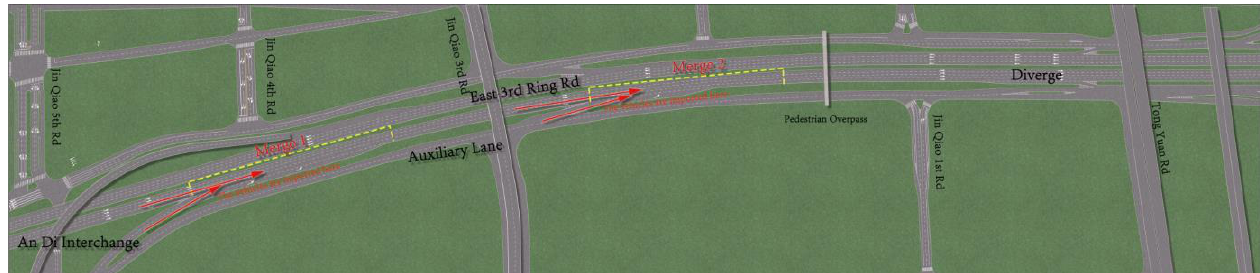
Figure 9. Survey road diagram.